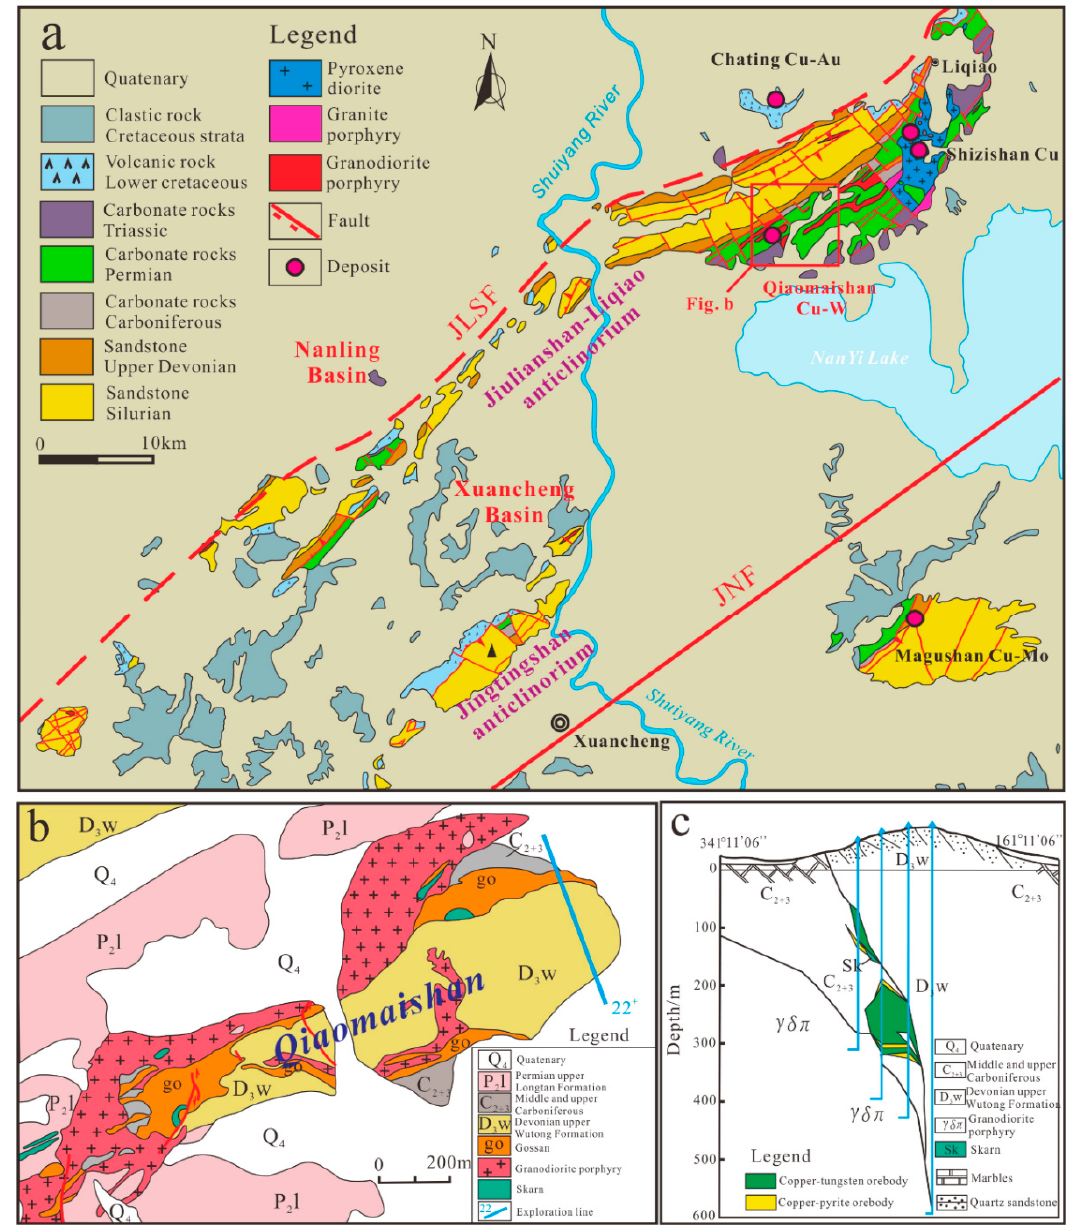
Figure 2. ( a ) Geological sketch map of the Xuancheng ore district (modified after [7]); ( b ) Geological map of the Qiaomaishan Cu–W deposit (modified after No.322 Geological Party, Bureau of Geology and Mineral Exploration of Anhui Province); ( c ) Section of the No. 22+ exploration line in the Qiaomaishan Cu–W deposit. Abbreviations: JLSF—Jiulianshan Thrust Fault; JNF—Jiangnan Fault.